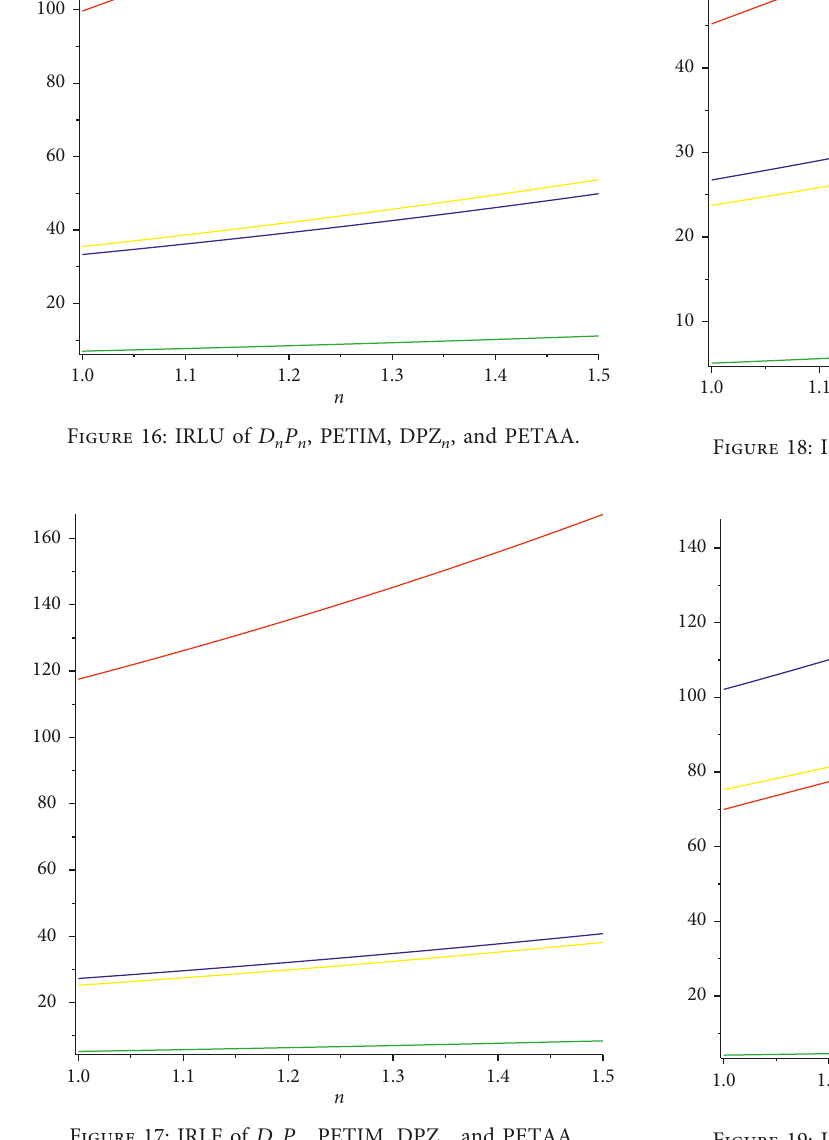
P n n , PETIM, DPZ n , and